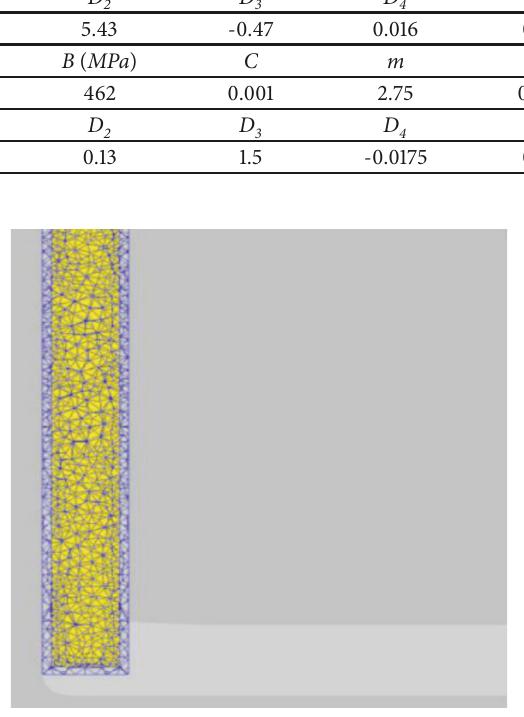
Figure 9: Structural diagram of ECAP with can.